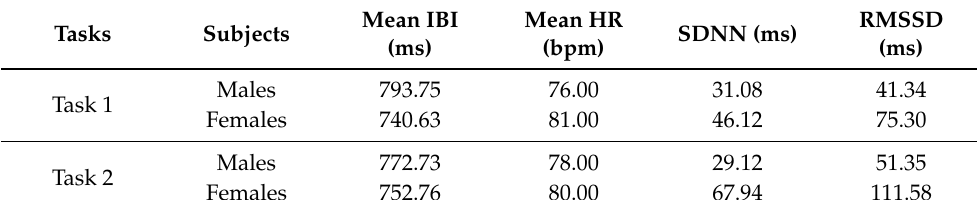
Table 6. HRV data for subjects of different genders in Task 1. Tasks